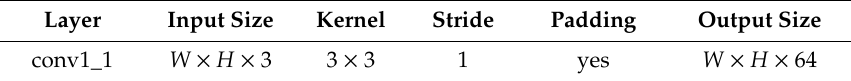
Table 2. Parameter configuration of conv1_1 layer.